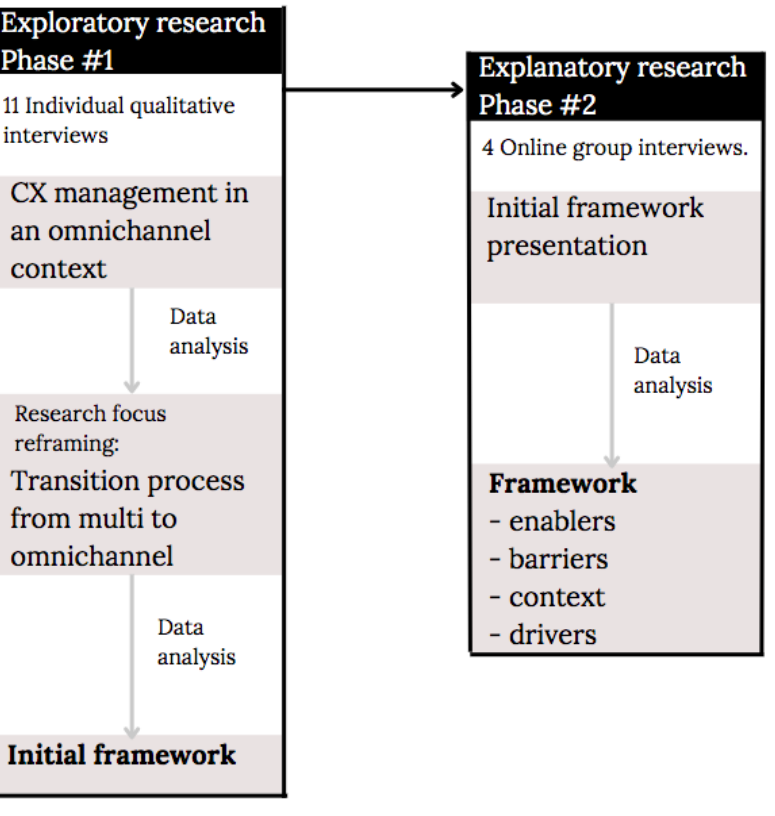
Figure 1. Research Figure 1. Research process.